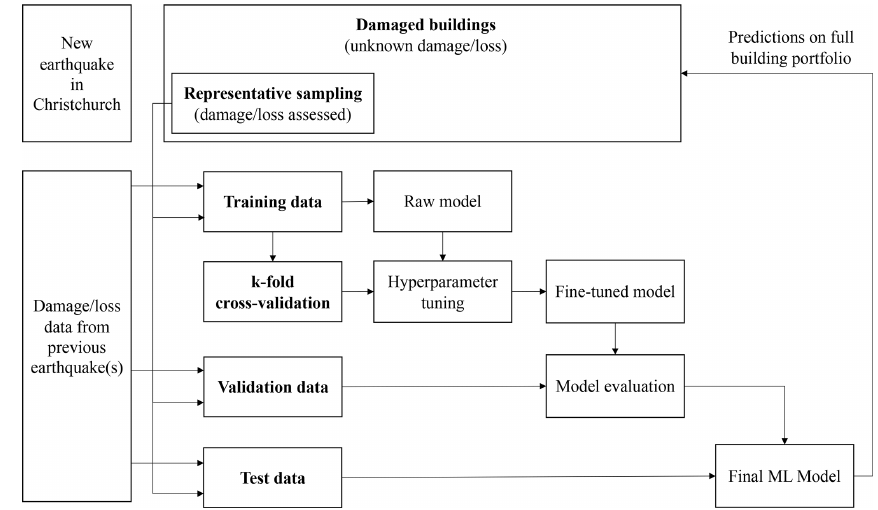
Figure 10. Overview of the training, validation, and test data sets and their usage in the development of an ML seismic loss model for